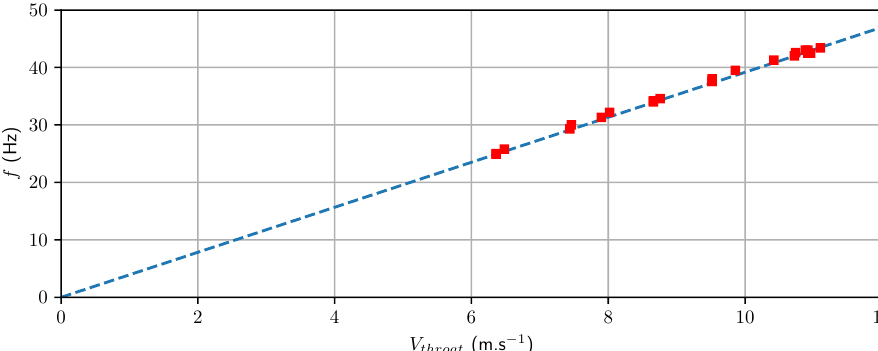
Figure 9. Measured frequency as a function of the throat velocity for type-2 regime. The dashed line is a linear fit of equation f = 3.83 V throat .